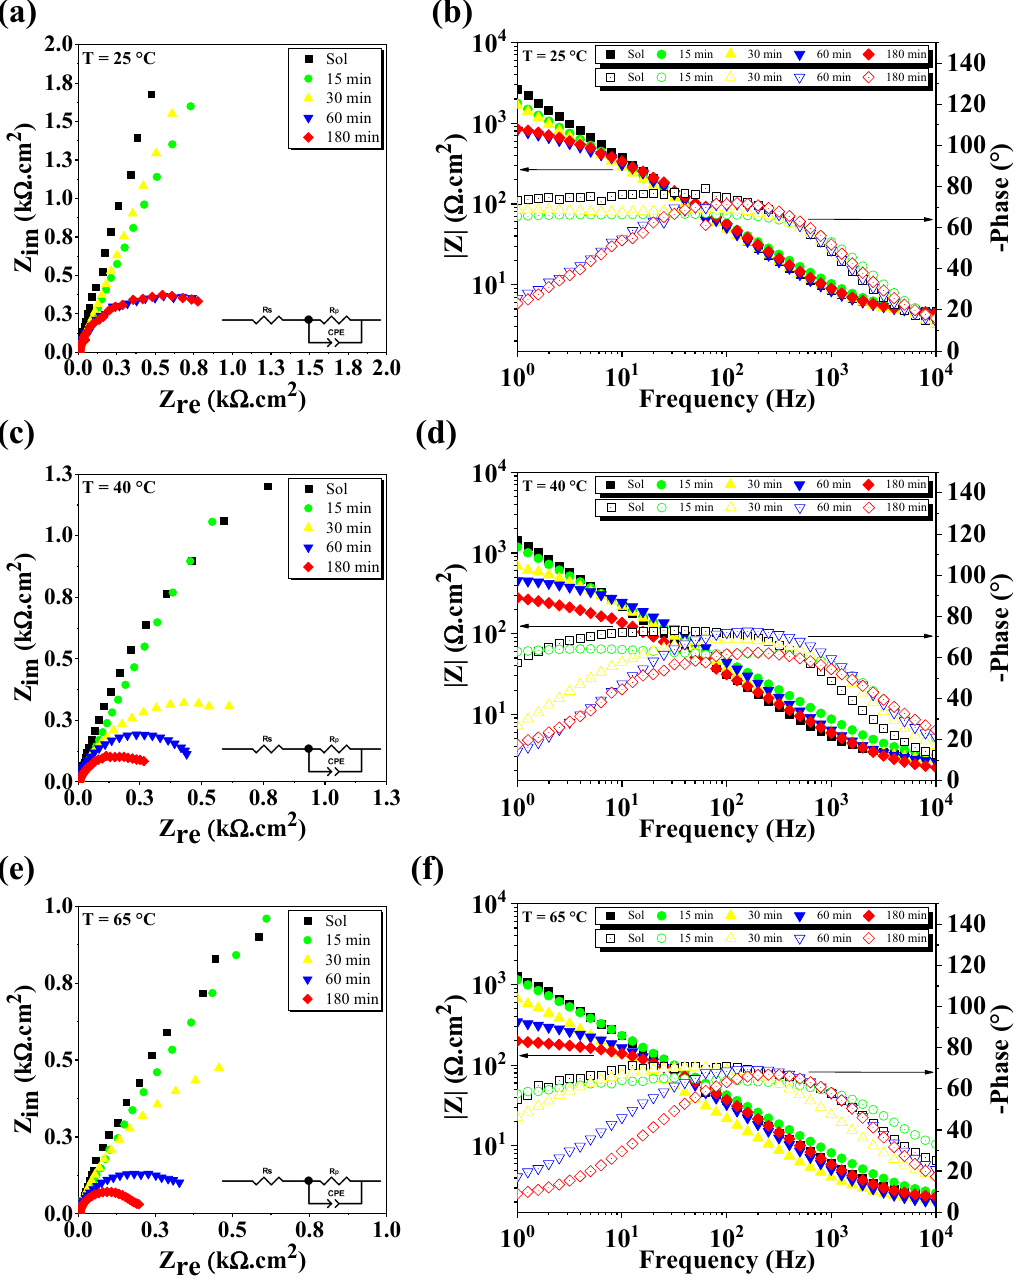
Figure 6. EIS results at: ( a , b ) 25 °C, ( c , d ) 40 °C, and ( e , f ) 65 °C.